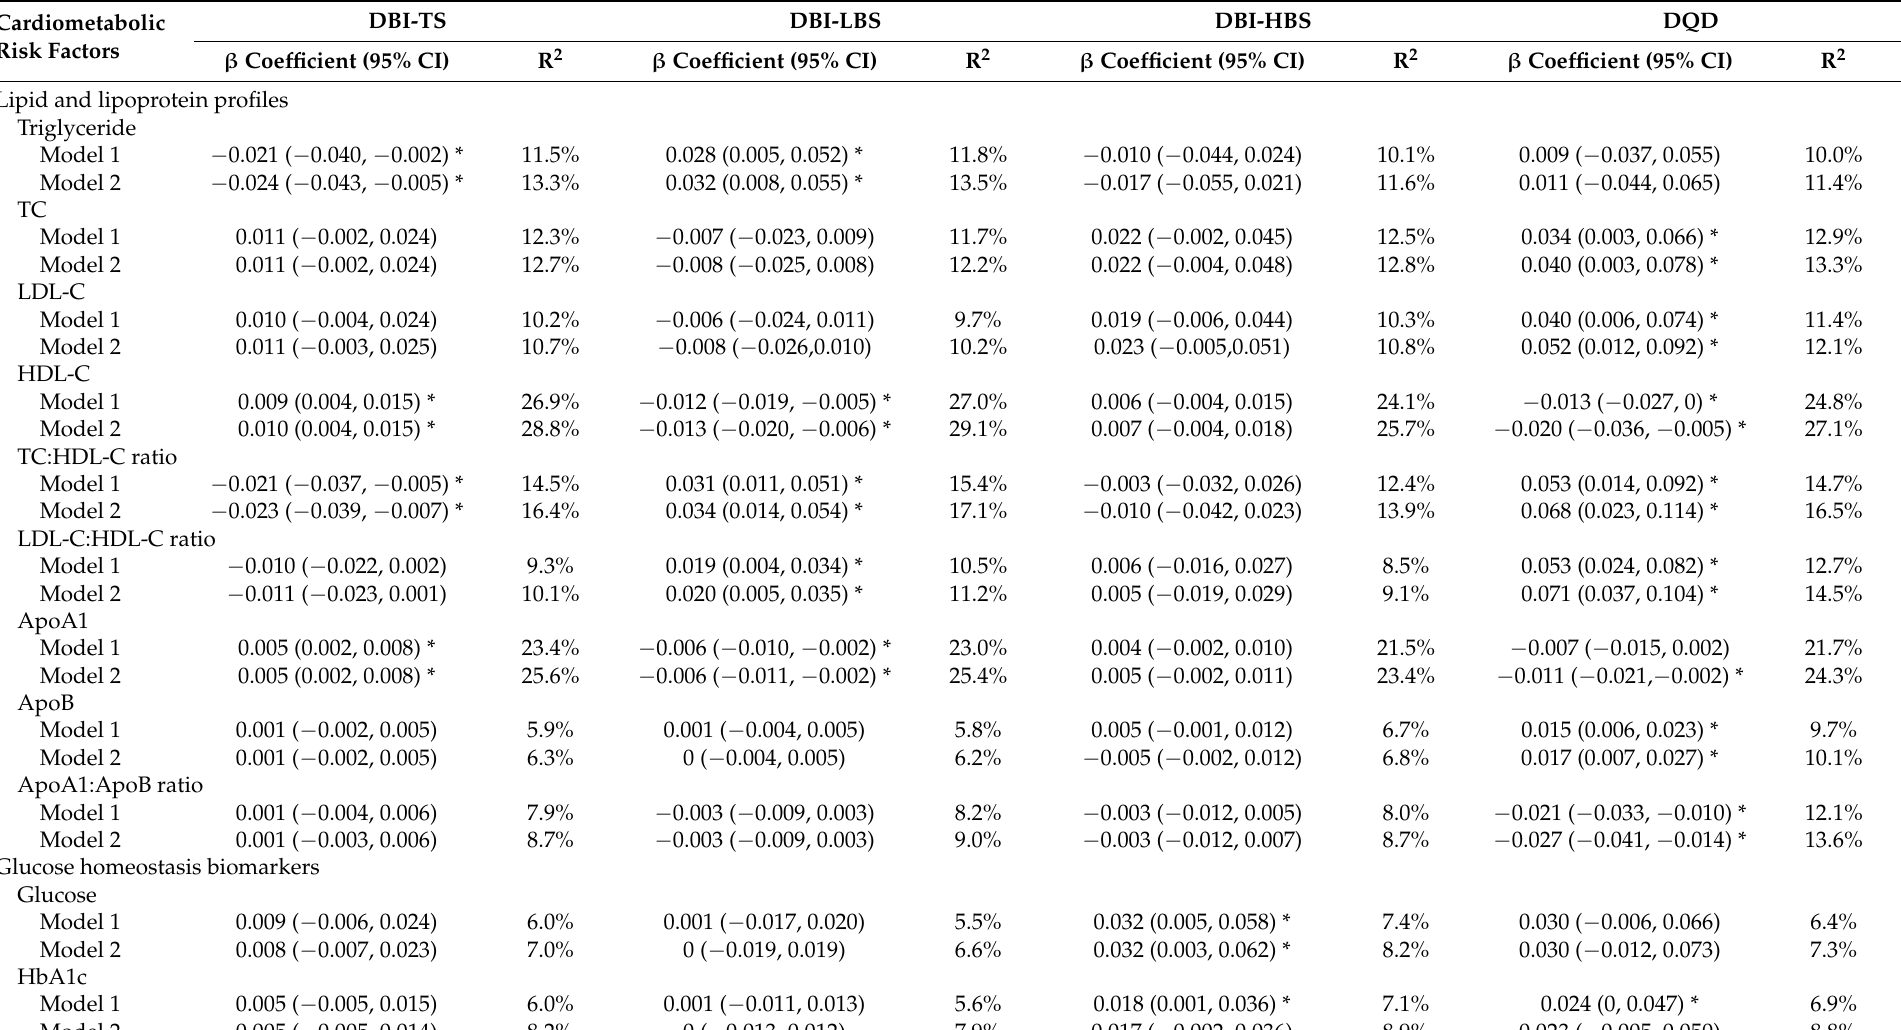
Table 5. Associations between DBI-16 scores and cardiometabolic risk factors among 269 Chinese participants with hyperlipidemia 1,2